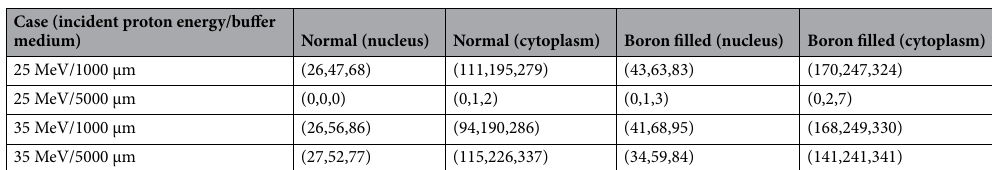
Table 4. Hit counts in the cell array from alpha particles for incident proton energies of 25 and 35 MeV with buffer medium thickness of 1000 µm and 5000 μm, for normal and boron filled cytoplasm and nucleus. The results present (lower bound, average, upper bound) values of hit counts obtained from three